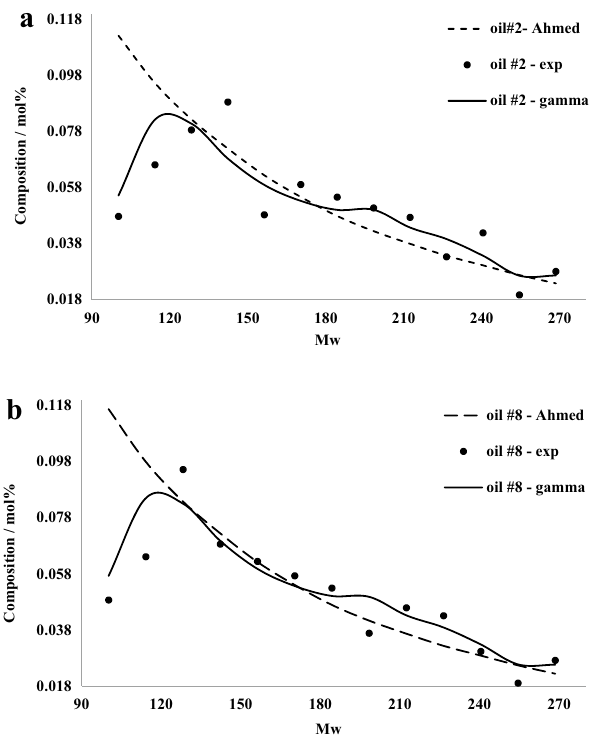
Fig. 1 Plus fraction splitting using gamma probability function and